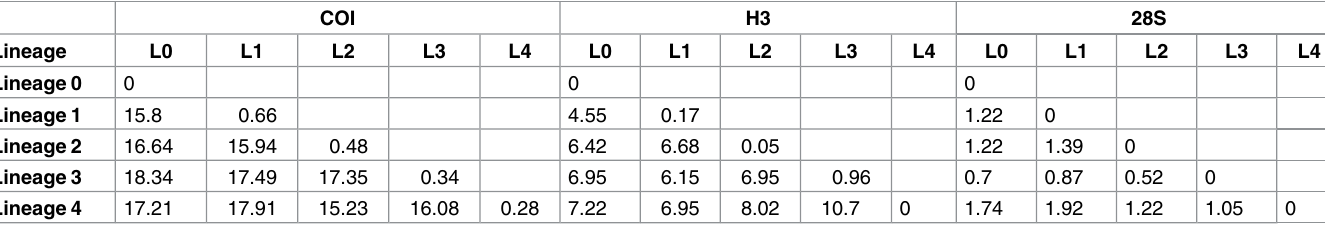
Genetic distances between genetic lineages (L0-L4) of Parisotoma notablilis . Genetic lineages refer to independent evolutionary units (IEUs) identified with